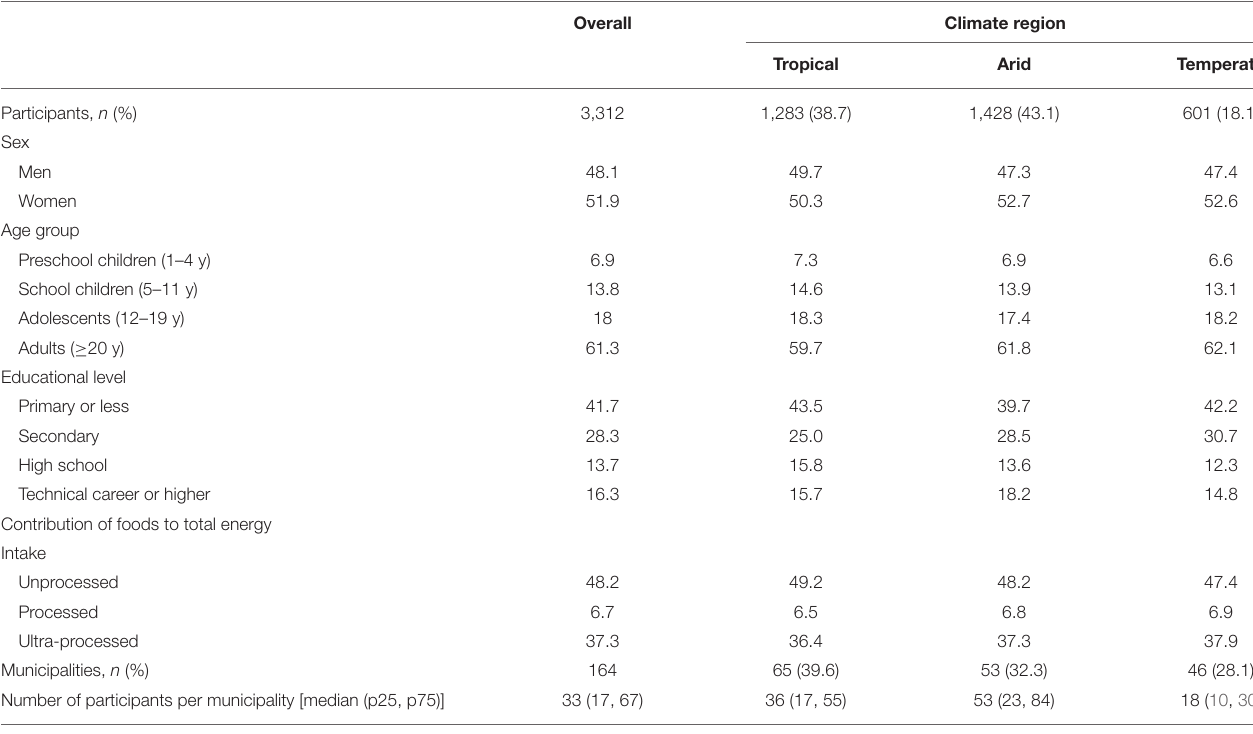
TABLE 1 | Characteristics of survey respondents included in analyses, overall and by climate region a . Overall Climate region Tropical Arid Temperate